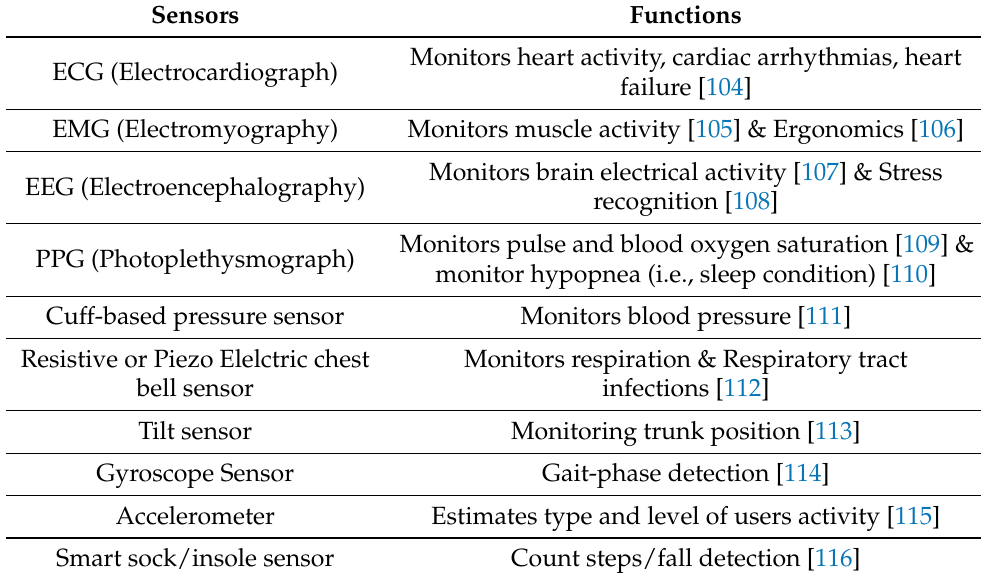
Table 4. Different wireless sensors used in